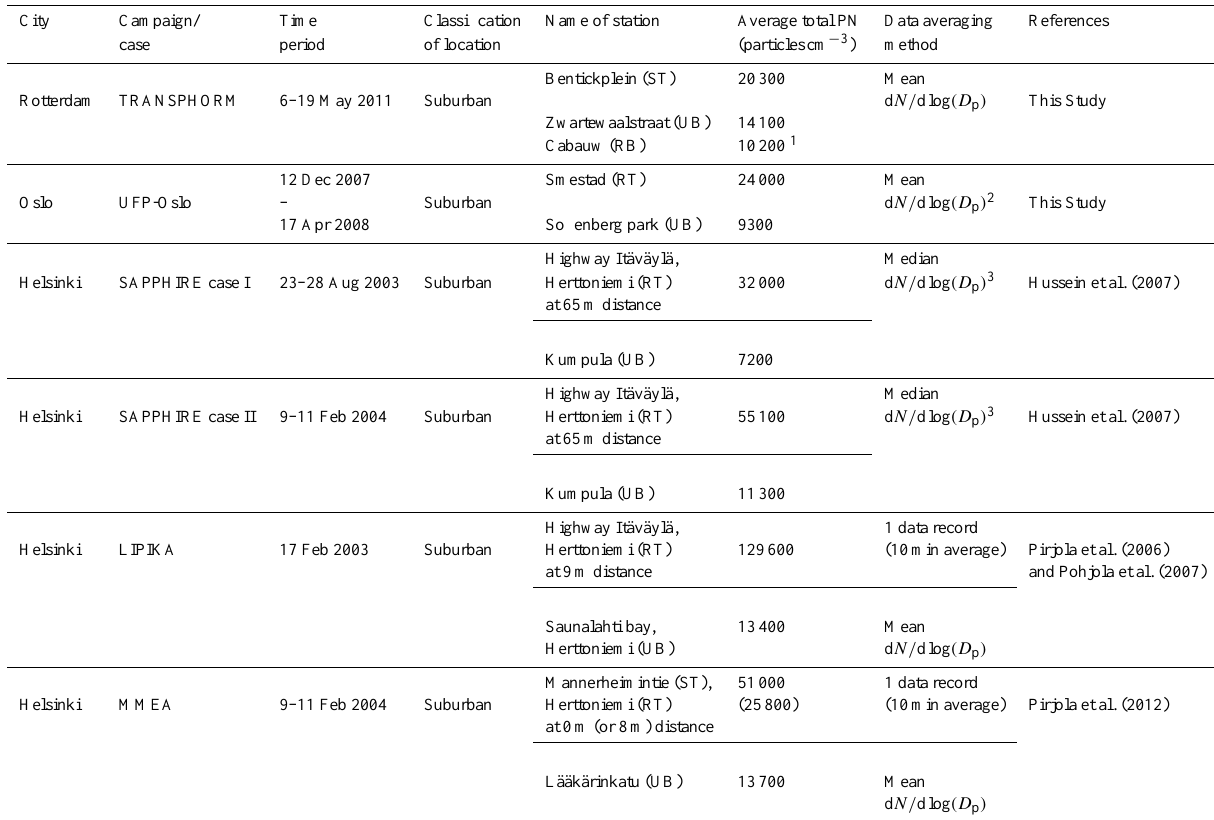
Table 3. Campaign number size distribution data used in this study. Notation: RT = roadside traffic site, ST = street canyon traffic site, UB = urban background, RB = regional